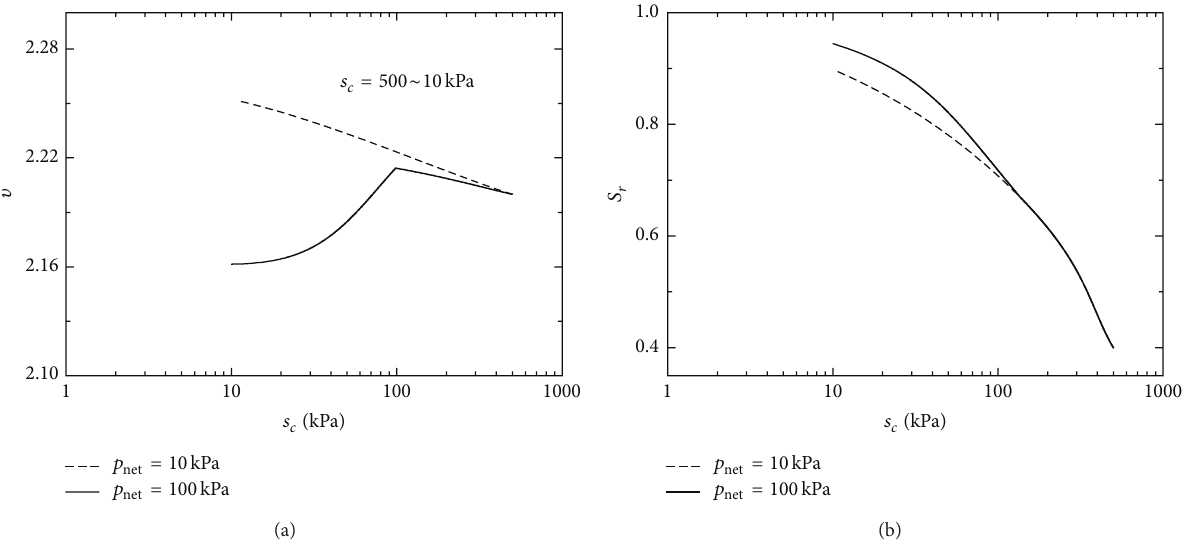
Figure 5: Model prediction for wetting tests at different net stresses: (a) relation between mean net stress and specific volume; (b) soil-water characteristic curve. It is assumed here that 𝑏 0 𝑟 = 6.5 , 𝑚 = 0.012 , and 𝜀 𝑝